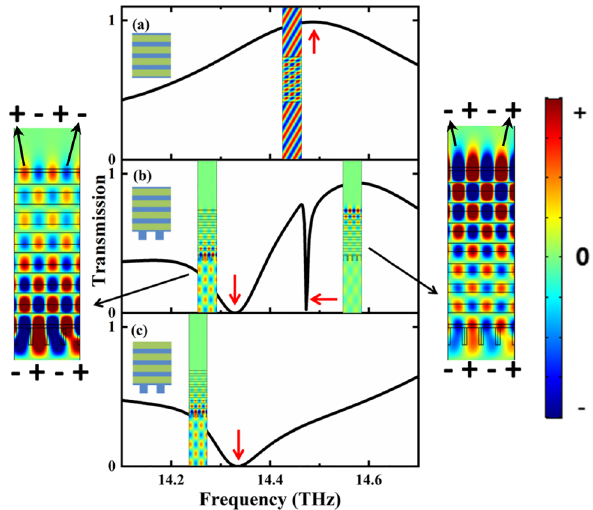
Figure 2: Simulated transmission spectra of three scenarios: (a) V 1 + V 2 + V 3 , note that there is no grating here, so that α = 0. t top = t grl = 2 μ m so that γ = 1. (b) V 1 + V 2 + V 3 + V 4 , note that α = 1, t grl = 2 μ m, γ = 1. (c) V 2 + V 3 + V 4 , here α = 1, t grl = 2 μ m, γ = 0. Thenumberofperiodiclayersinthephotonicscrystals(PCs)is N =8. Thedistributionoftheelectric fi eldin z directionispresentednextto the resonance peak. The red and blue in the color bar indicate “ + ” and “ － ” ,